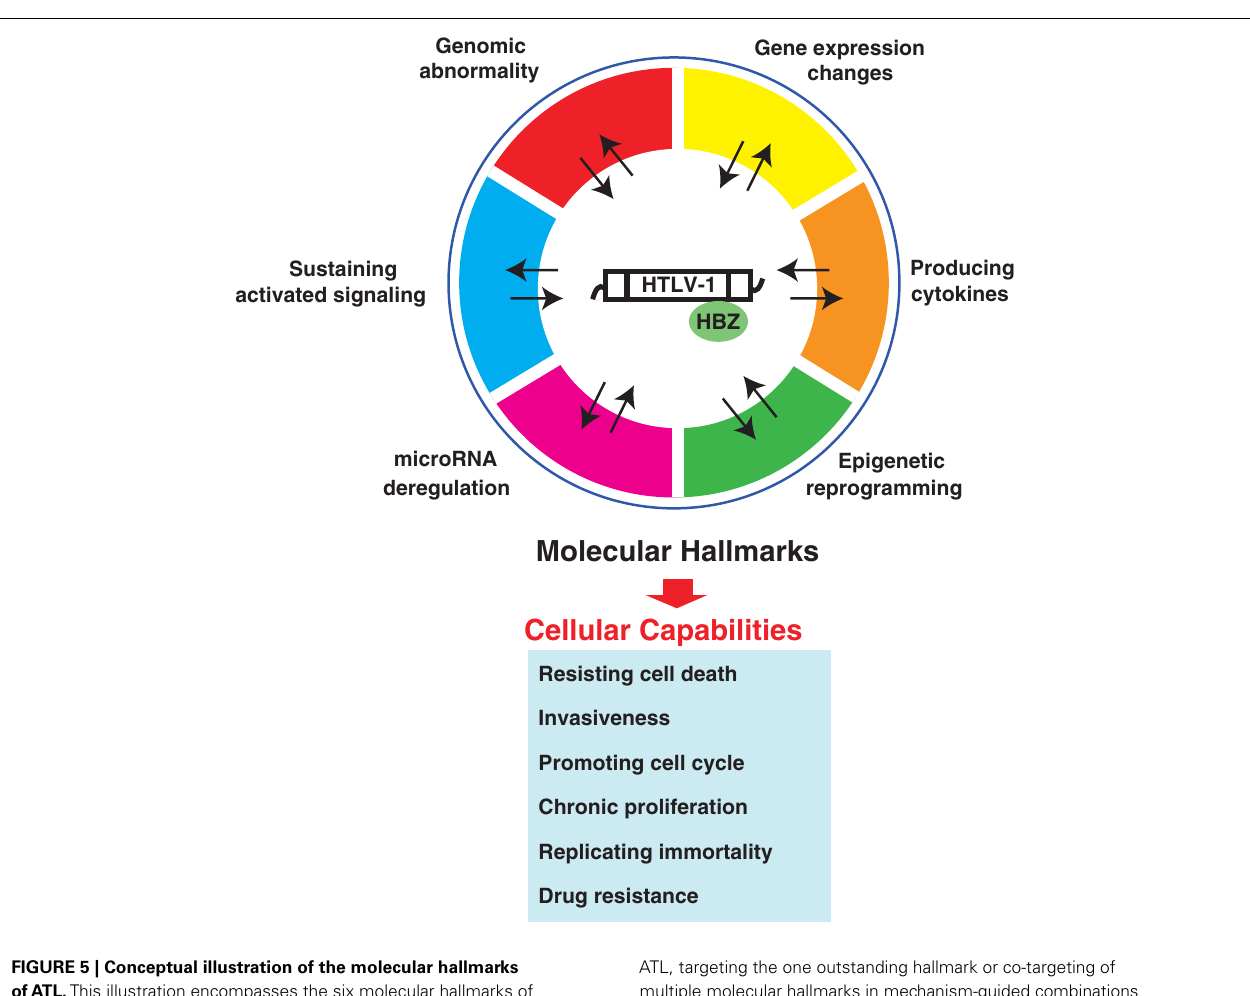
ATL, targeting the one outstanding hallmark or co-targeting of multiple molecular hallmarks in mechanism-guided combinations will result in more effective and durable therapies for aggressive